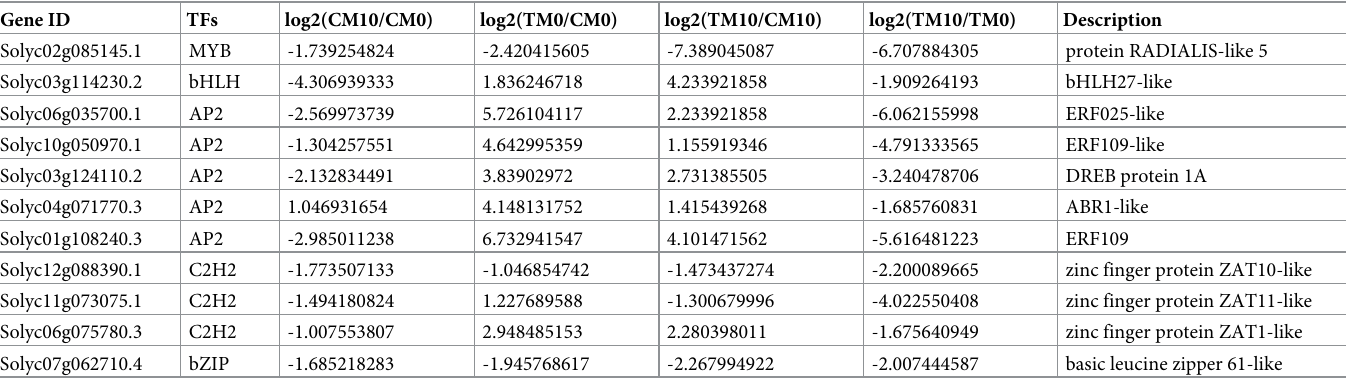
Table 2. Transcription factor related DEGs shared by four groups. Gene